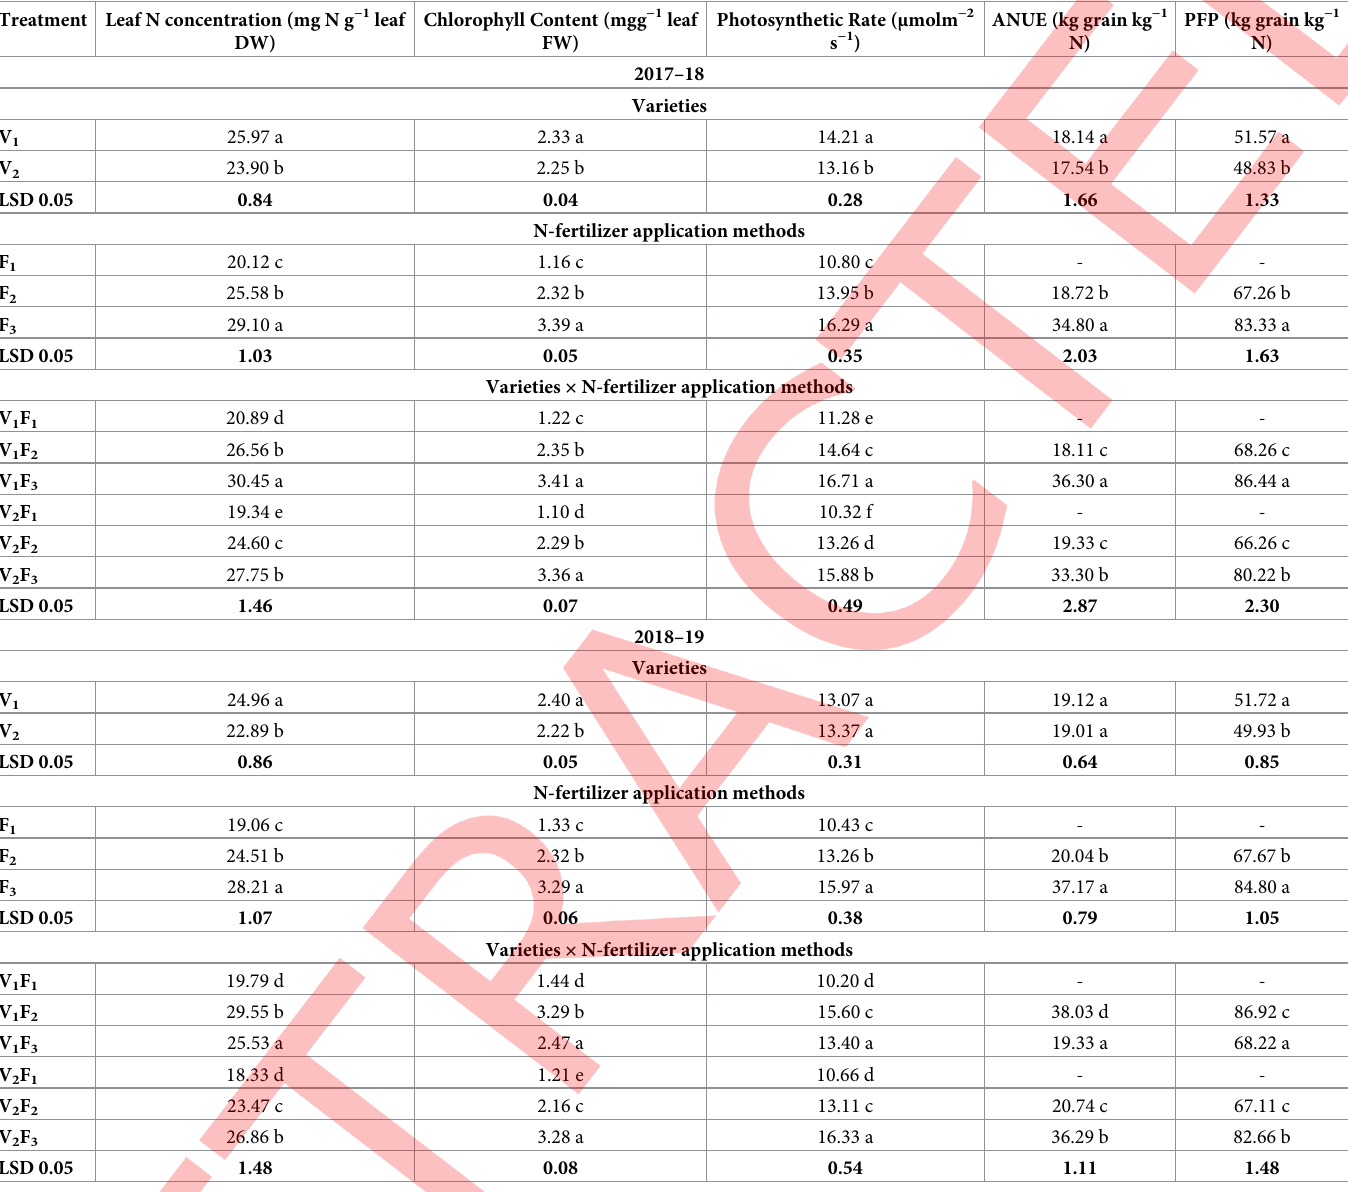
Table 3. The impact of nitrogen fertilizer application methods on nitrogen uptake, chlorophyll contents, photosynthesis rate, agronomic N use efficiency (ANUE), and partial factors productivity of applied N (PFP) of transplanted fine rice. Treatment Leaf N concentration (mg N g − 1